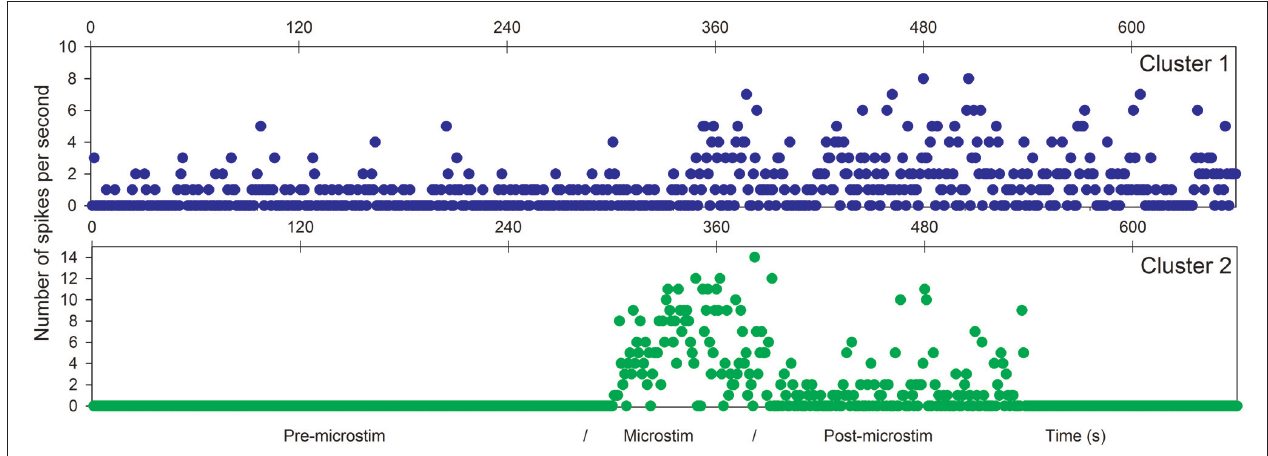
FIGURE 4 | Microstimulation within a cortical dysplasia (patient D1, 1 Hz). Effects of microstimulation on spike frequencies illustrated with histograms of spike occurrences during the whole recording (ordinate: number of spikes per second, before, during and after microstimulation; time indicated in